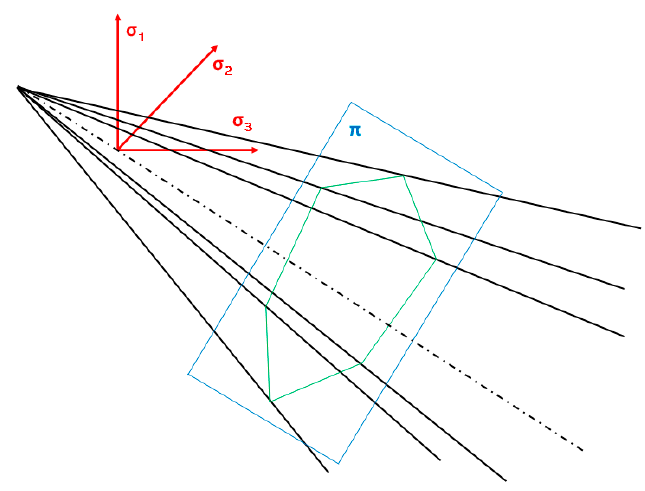
Figure 3. Plasticity area in the Coulomb–Mohr model.